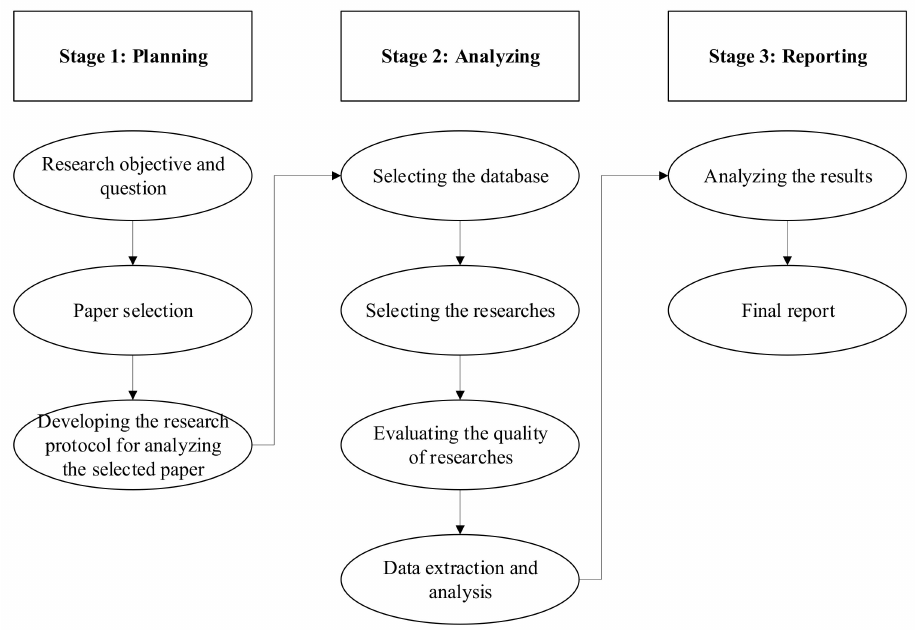
Figure 1. Steps of the literature review